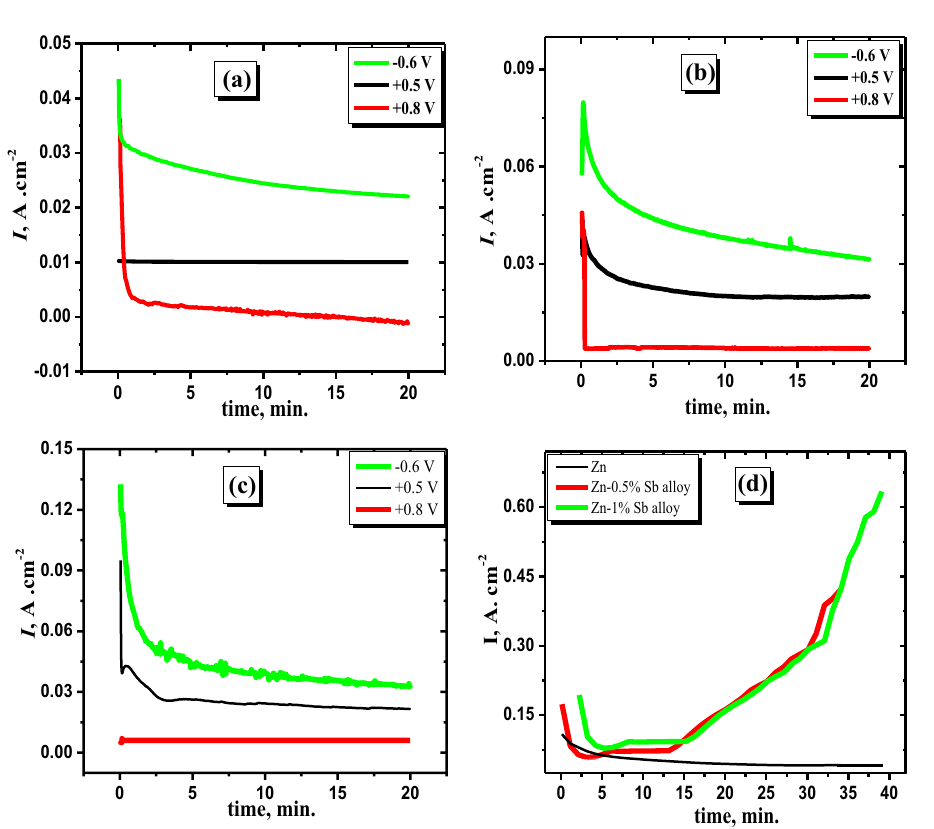
Figure 4. Potentiostatic (current–time) data for Zn ( a ) and its alloys I ( b ) and II ( c ) in 6 M KOH at various potentials as labeled and comparison between Zn and its alloys at breakdown voltage + 2.0 V ( d